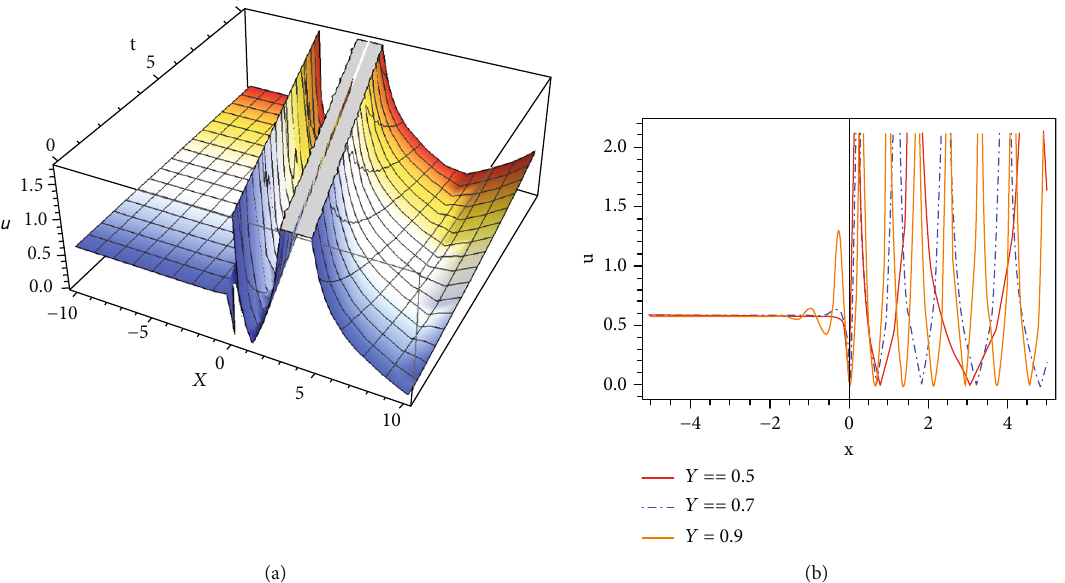
= 1 , T = 2 , V = 1 , c = 3 , a = 1 , b = 1 , and γ = 0 : 5,0 : 7,0 : 9 for the solution j u 1 ð x , t Þ with distinct values of γ 16